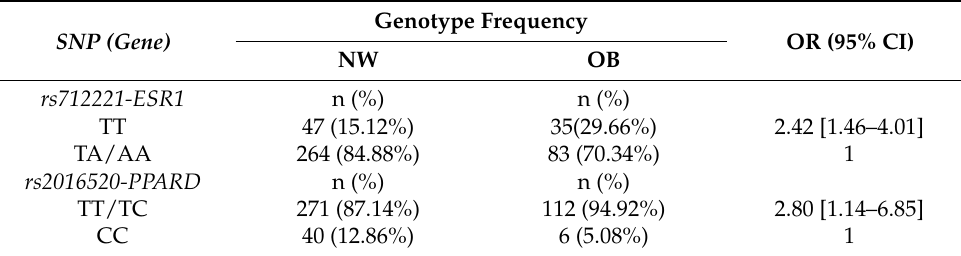
Table 2. The risk-genotype analysis of rs712221 and rs2016520 among normal-weight and obese participants. SNP (Gene)